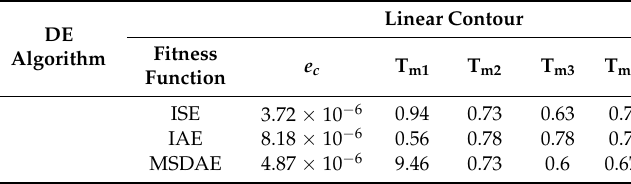
Table 6. Mean torques and contour errors.